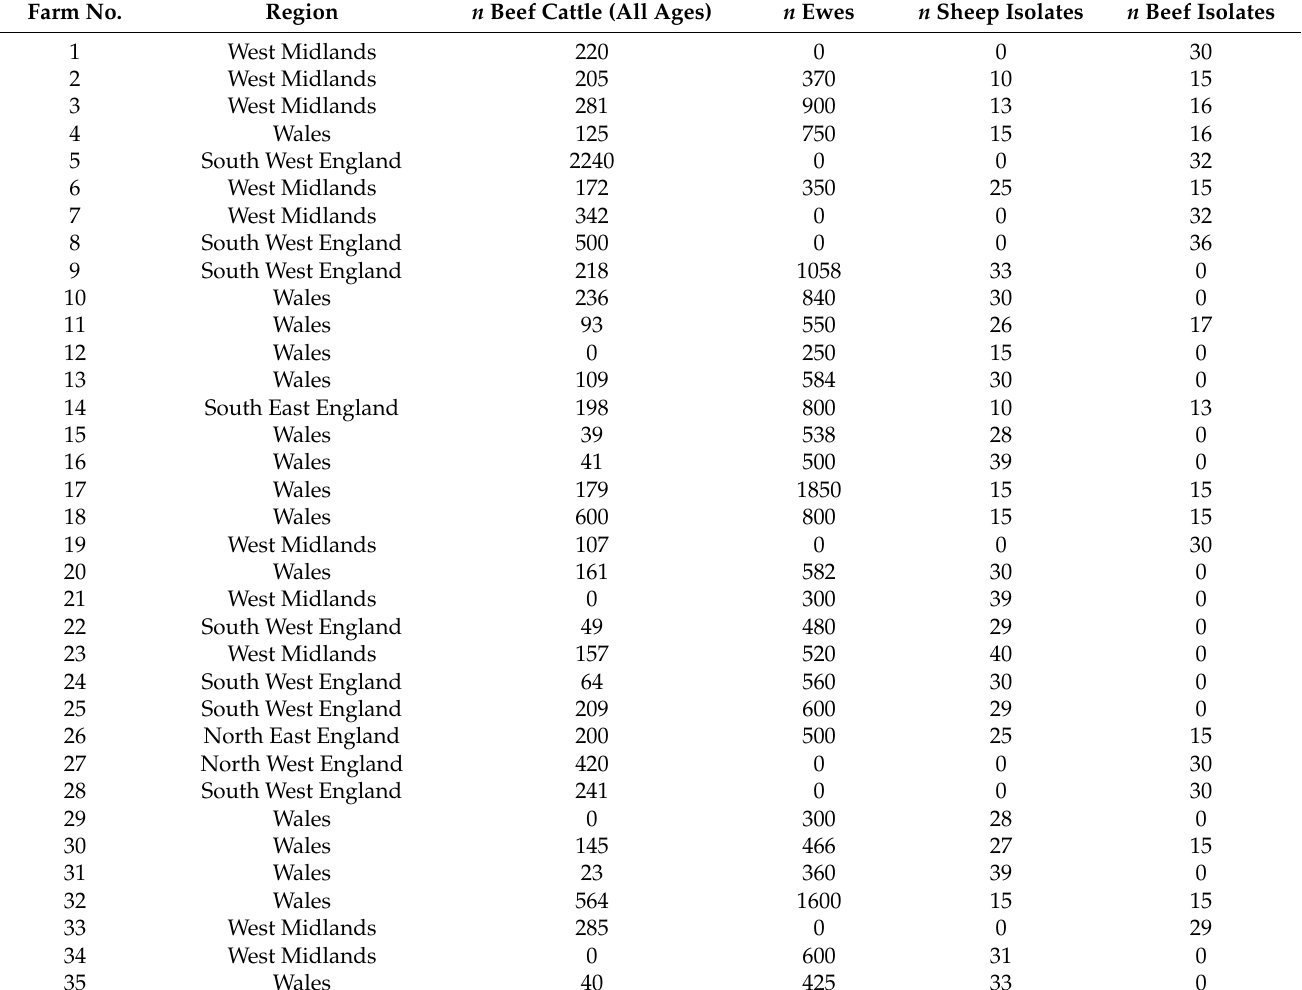
Table 1. Description of the farms where E. coli isolates were obtained including number of animals, region and number of isolates tested. Farm